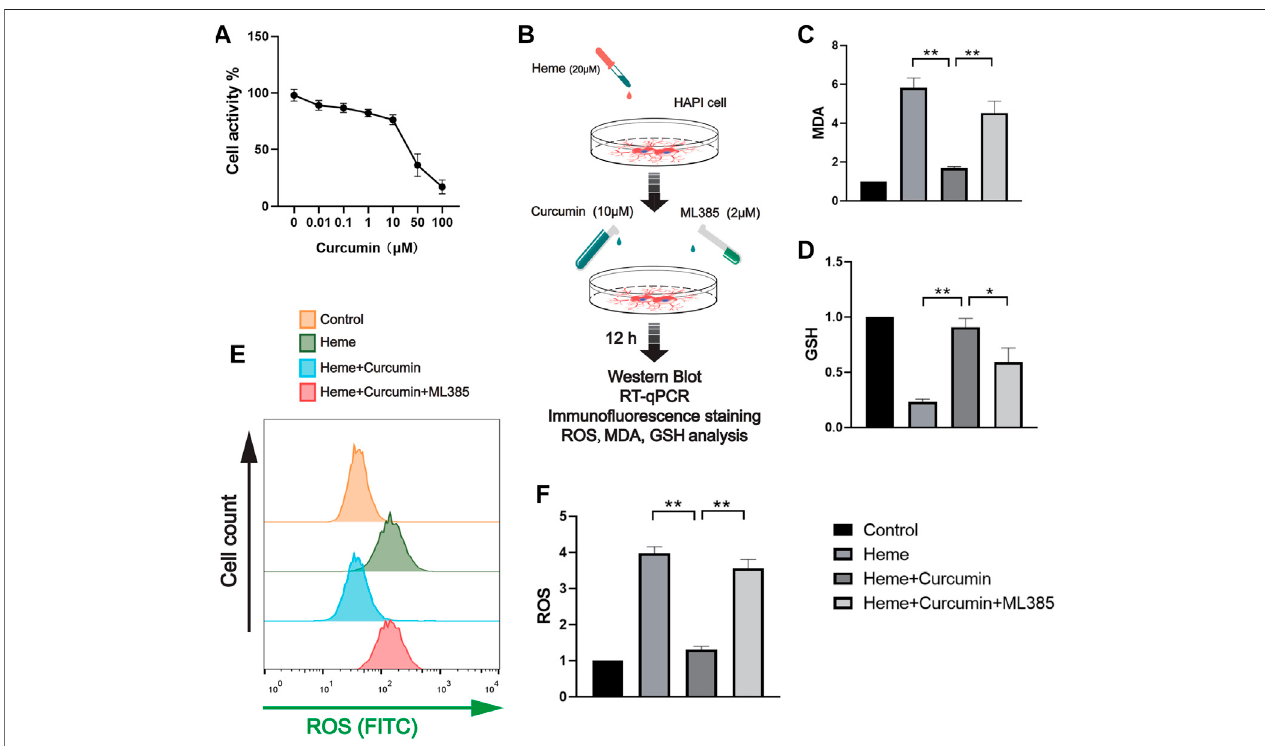
FIGURE 2 | Curcumin was con fi rmed to promote the antioxidant function of HAPI cells. (A) The activity of the HAPI cells treated with curcumin at different concentrations for 12 h was determined, and the cellular activity of the cells was evaluated by the CCK-8 analysis. (B) In vitro experimental procedures. (C,D) Based on the CCK-8 analysis,the heme-inducedHAPI cells weretreated withcurcumin(10 μ M) for12 h, then thelevelsofMDA and GSH weredetermined. (E) AfterROSineach group were labeled by FITC, fl ow cytometry results were performed. (F) ROS levels in HAPI cells were measured with a microplate reader. Data are shown as the means ± SD of n = 3 samples/group and at least three independent experiments were performed. Statistical analyses were conducted using two-way ANOVA. *, p < 0.01 and **, p < 0.01.